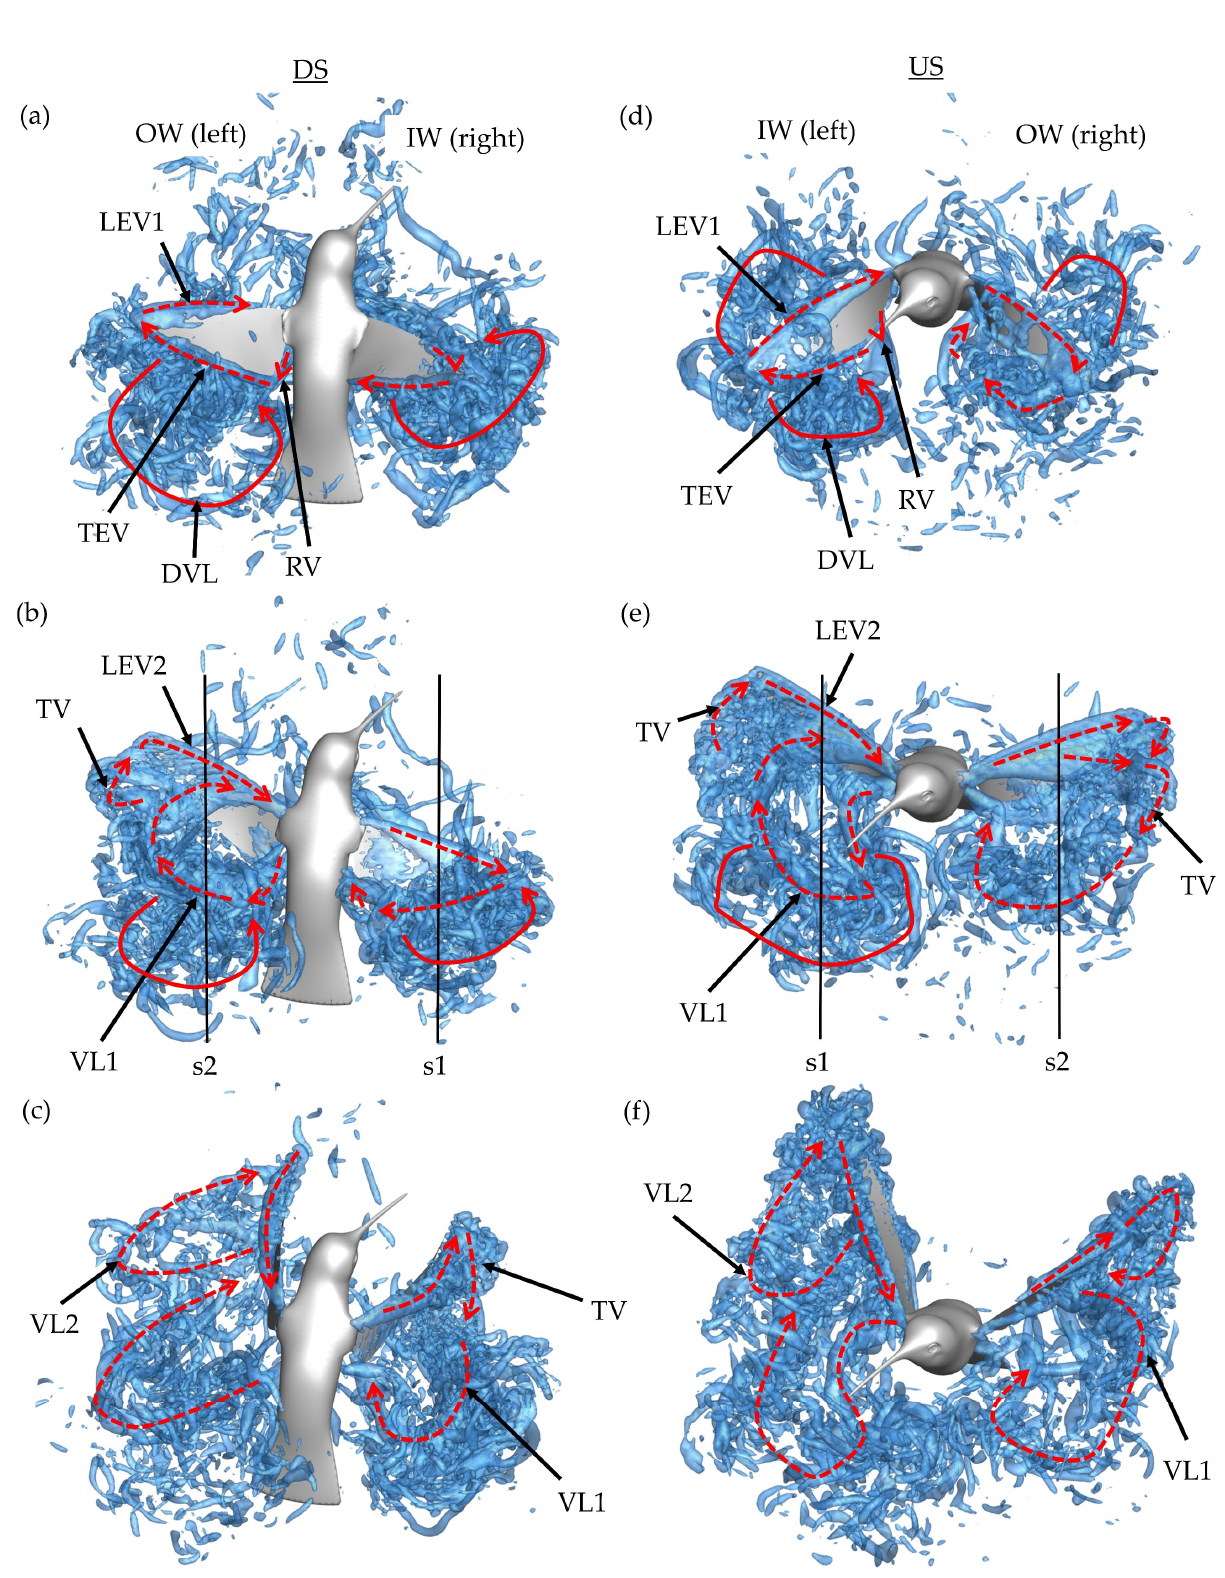
Figure 8. Wake topology generated by the hummingbird’s third DS at ( a ) t/T* = 0.16, ( b ) t/T* = 0.32, and ( c ) t/T* = 0.48 and third stroke US at ( d ) t/T* = 0.60, ( e ) t/T* = 0.72, and ( f ) t/T* = 0.98. The lines labelled s1 and s2 in ( b , e ) denote the slices that the data in Figure 9 are shown